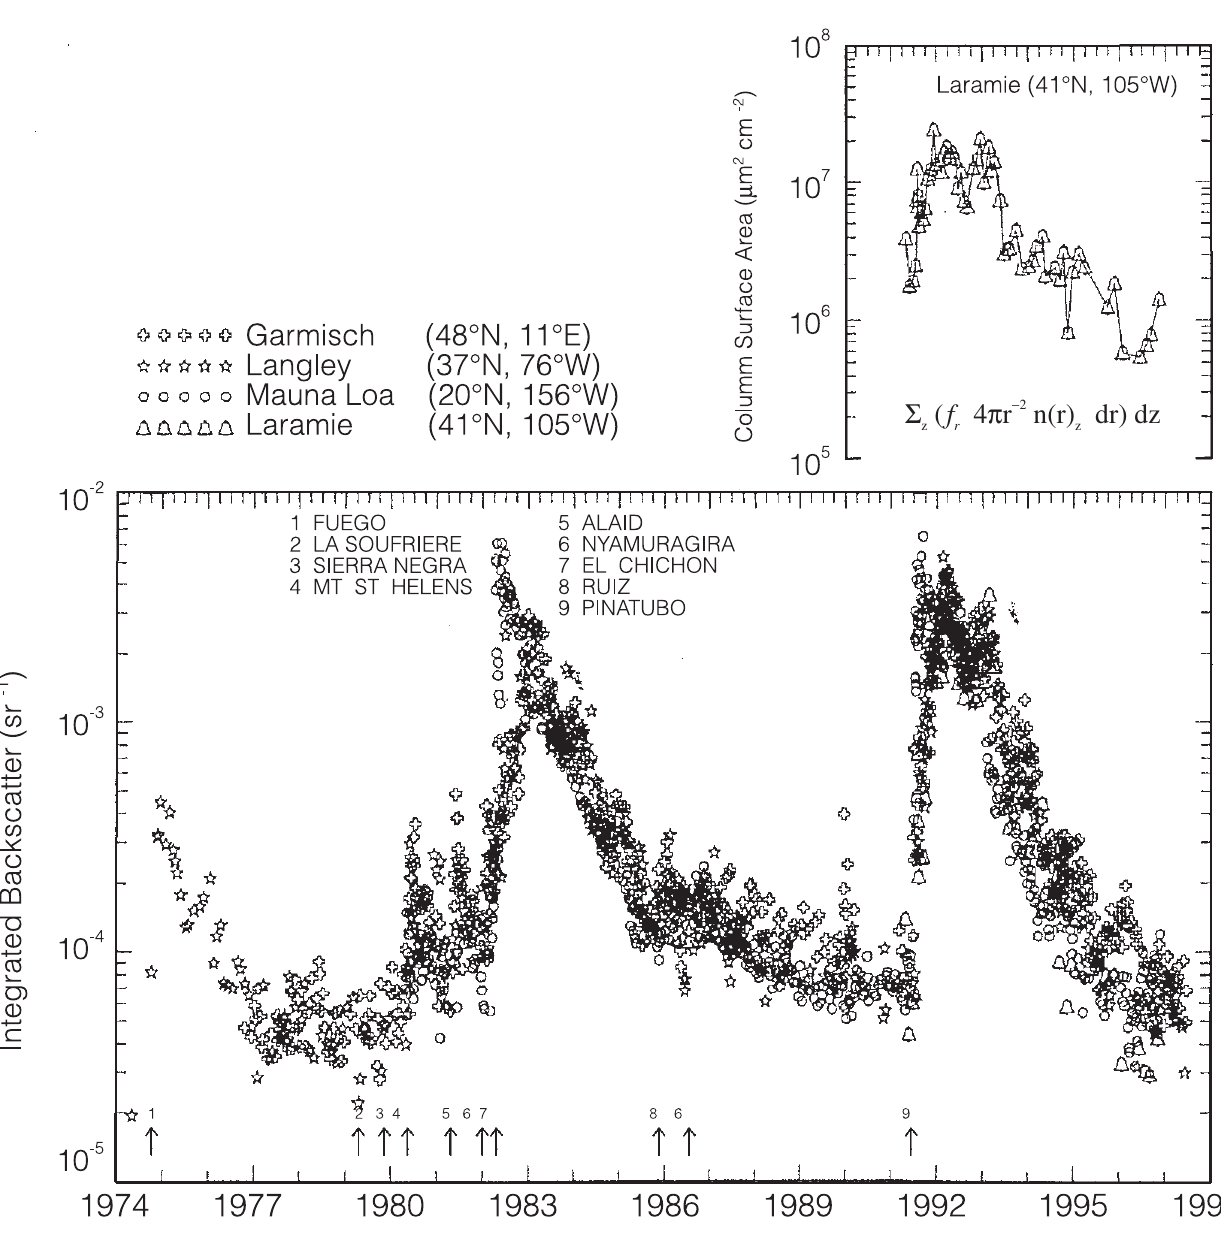
Fig. 2. Time variation of the stratospheric aerosol layer at Northern Hemisphere midlatitudes. The plot shows the integrated aerosol backscatter at a wavelength of 0.6943 m m from lidar measurements at Garmisch-Partenkirchen, NASA Langley, and Mauna Loa for the period 1974-1998. Also shown for the period 1991-1997 is integrated aerosol backscatter calculated from size distributions fi tted to in situ data above Laramie. The calculations assume particles with an index of refraction of 1.45. Also shown are column integrals of surface area from the 1991-1997 in situ data. The column integrals are from the tropopause to near 33 km for all the data. Arrows indicate prominent volcanic eruptions (World Meteorological Organization,